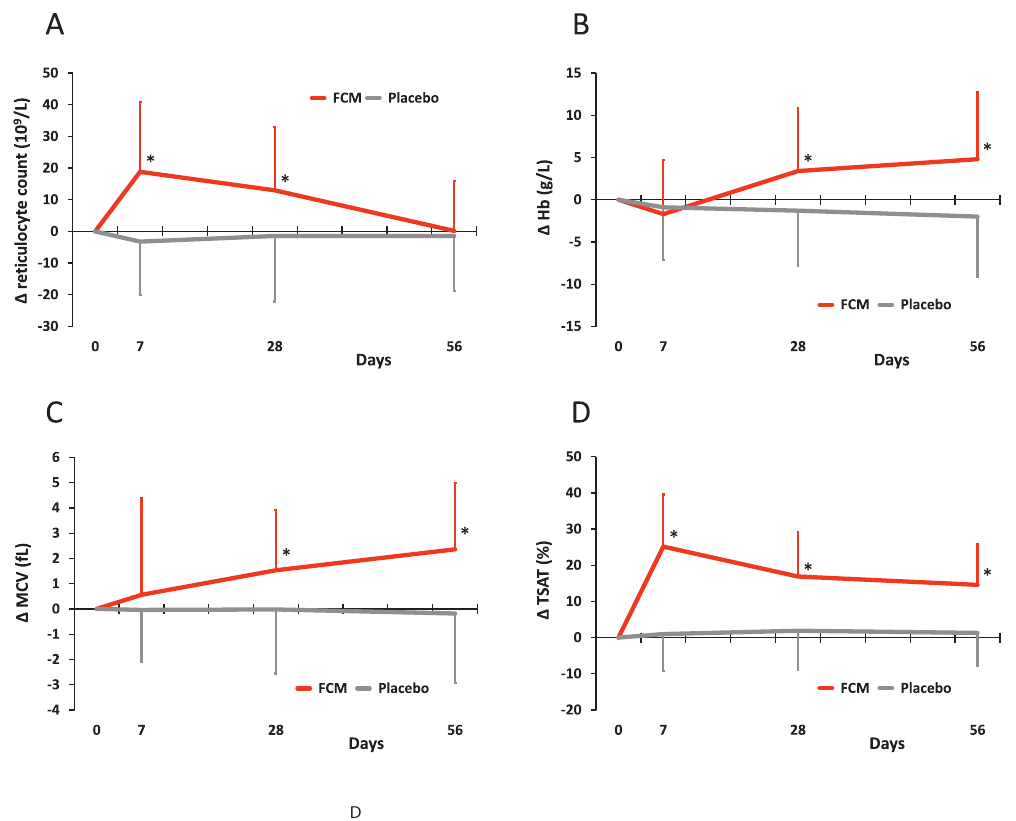
Figure 3. Mean changes ( D ) in reticulocyte counts, Hb levels, MCV and TSAT (error bars SD). The rapid increase of reticulocyte counts in the FCM group is in line with early FCM-associated improvement of the fatigue total score (fig. 2B). The significantly higher increase in reticulocyte counts in the FCM group at Days 7 and 28 (A) translated into higher increases of Hb and MCV at Days 28 and 56 (B,C). The early FCM-associated increase in reticulocyte counts remained significantly higher compared to placebo when analysing the subgroup of patients with Hb $ 120 g/L (P , 0.001 for Days 7 and 28). This suggests that iron deficiency without anaemia affected erythropoiesis in these apparently healthy women and raises doubts whether the currently recommended Hb cut-off level of 120 g/L to diagnose anaemia in premenopausal, menstruating women is appropriate. TSAT remained significantly improved until the end of the 56-day study period (D). *P , 0.0001 for difference between FCM and placebo group in reticulocyte counts and Hb levels, respectively.